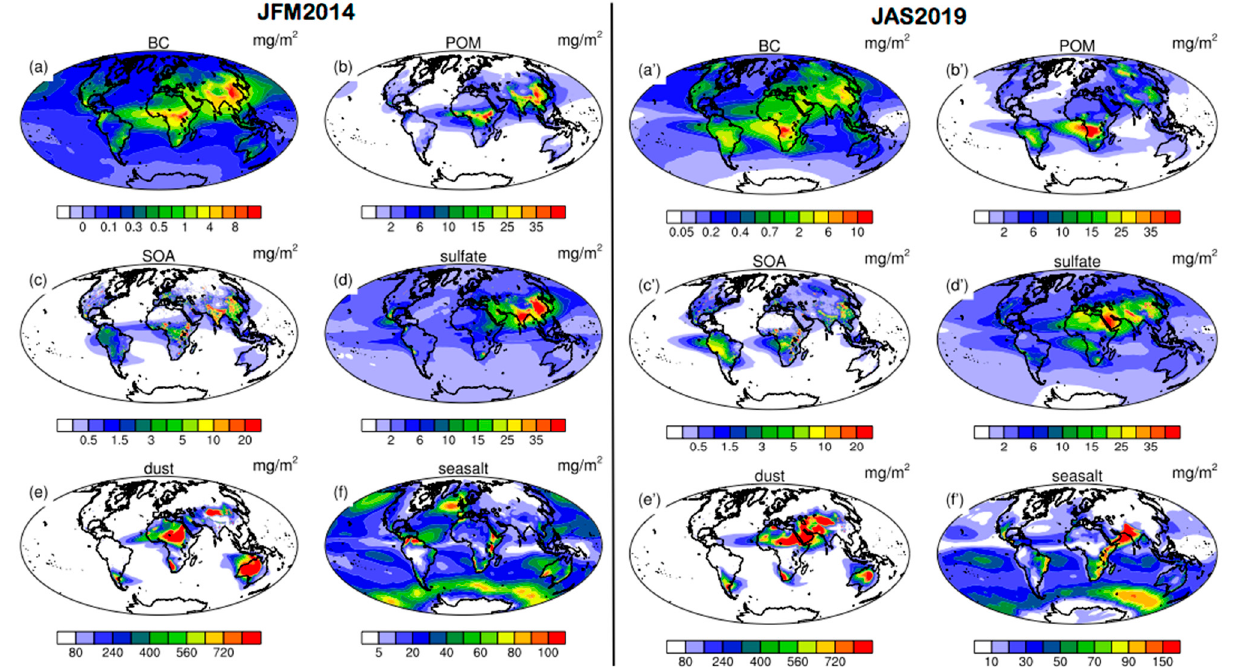
Figure 2. Total column mass concentrations (in mg/m 2 ) of MAM4 species (BC, POM, SOA, sulfate, DU, and SS) summed over modes in BAM AMIC experiments. ( a – f ) (left panel) Averaged for JFM2014 period, and ( a’ – f’ ) averaged for JAS2019. Table 2. Global mean total column mass concentrations (in mg/m 2 ) of MAM4 species (BC, POM, SOA, sulfate, DU, and SS) summed over modes for JFM2014 and JAS2019 in BAM AMIC experi- ments. JFM2014